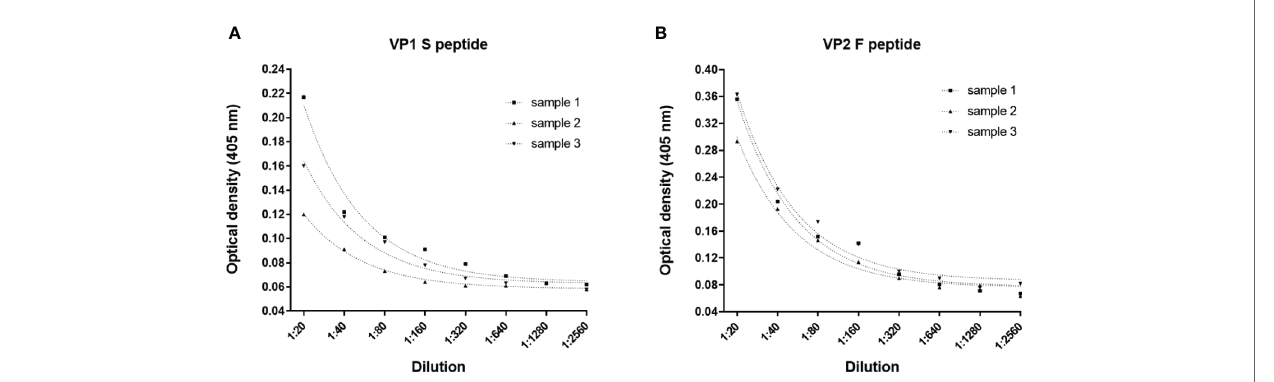
FIGURE 3 | Dilutional linearity of the indirect ELISA. Optical Density (OD) response to serial dilutions (1:20, 1:80, 1:160, 1:320, 1:640, 1:1,280 and 1:2,560) of n=3 MCPyV-positive sera presenting known high ODs. Each dilution was assayed in triplicate for each MCPyV VP1 S and VP2 F peptide, and ODs and sera dilutions were compared by linear regression analysis. (A) Good correlation between ODs and dilutions was found for VP1 S peptide with an R 2 of 0.9781 (p<0.0001), 0.9925 (p<0.0001) and 0.9809 (p<0.0001) for samples #1, #2 and #3, respectively. (B) Good correlation between ODs and dilutions was found for VP2 F peptide, with an R 2 of 0.9793 (p<0.0001) for sample #1, 0.9851 (p<0.0001) for samples #2 and 0.9853 (p<0.0001) for samples #3.